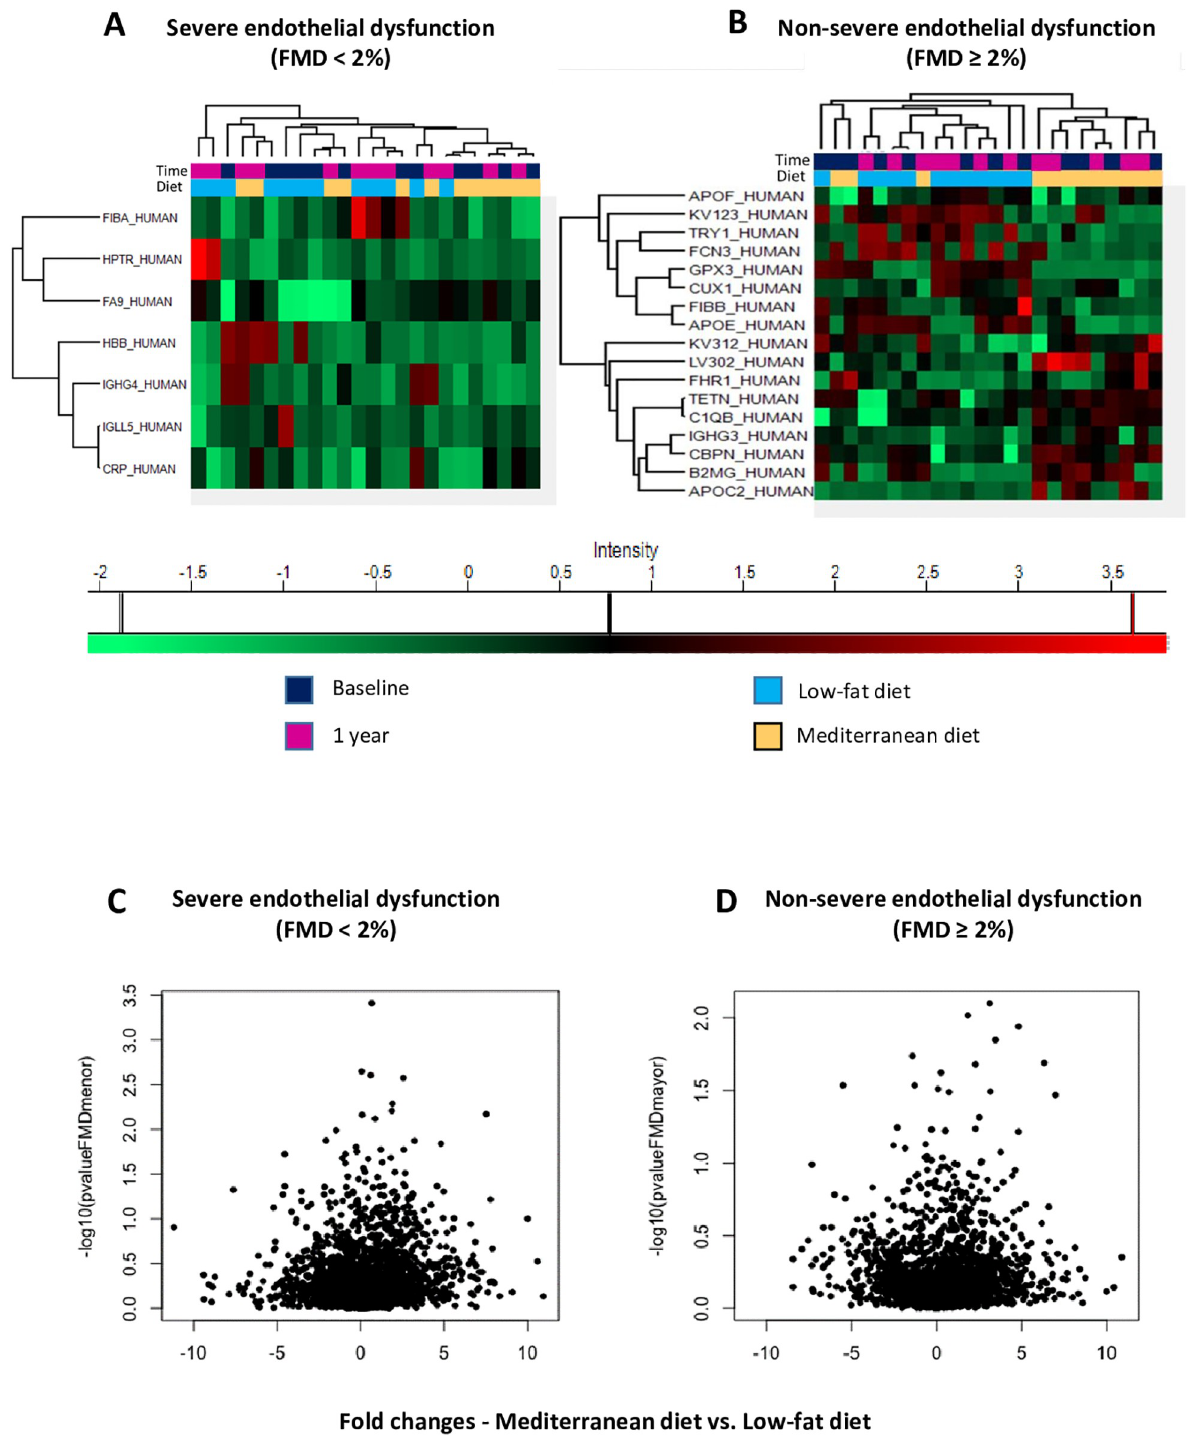
Fig 7. Protein and miRNAs pattern differentially expressed in serum samples according to time and diet interaction. (A) Heatmap of differentially expressed serum proteins in patients with severe endothelial dysfunction. (B) Heatmap of differentially expressed serum proteins in patients with nonsevere endothelial dysfunction. Eight and nine proteins were up- and down-regulated, respectively, after consumption of the low- fat diet, and inversely after consumption of the Mediterranean diet. (C) Volcano plots to assess significant changes of miRNAs expression after 1 year of each dietary intervention and according to FMD < 2%; D) Volcano plots to assess significant changes of miRNAs expression after 1 year of each dietary intervention and according to FMD � 2%. The selection criteria of miRNAs with a fold change greater than 1.5 and p -value > 0.05 ( − log10